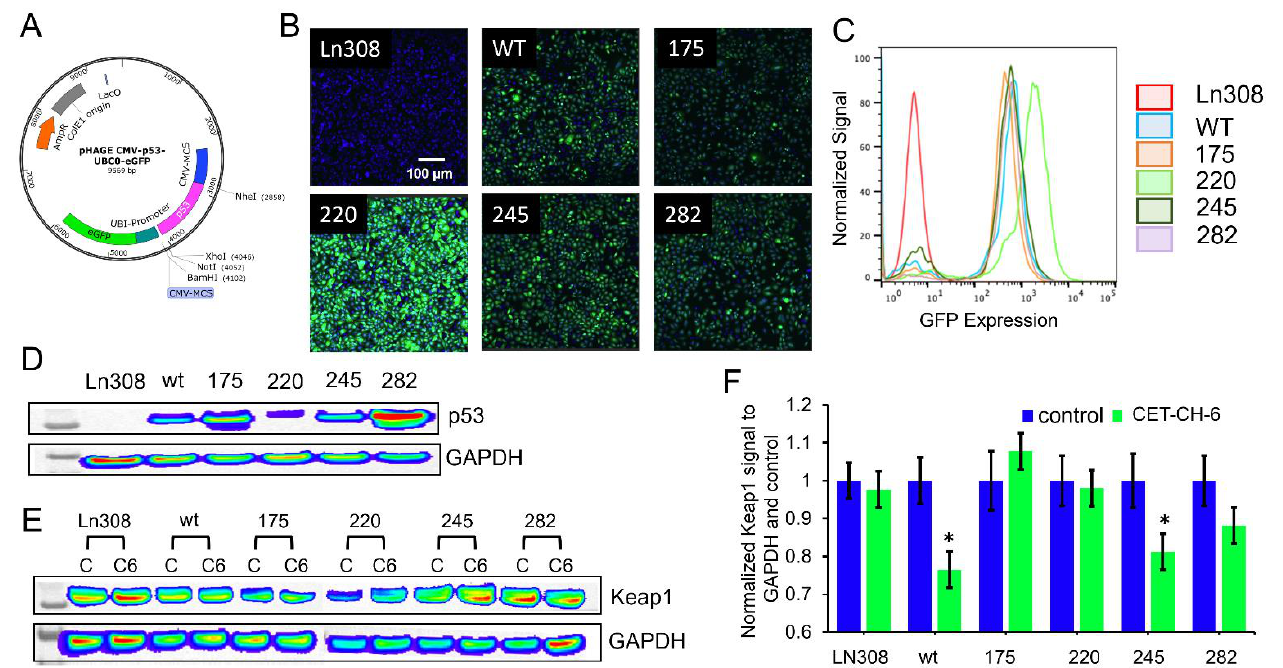
Figure 4. LN308 cell line with no p53 expression engineered to stably express structural p53 variants at different locations. ( A ) the vector designed for the transduction of LN308 cell line to stably express p53 wild-type as well as five different structural mutations in the frequently mutated sites at the DNA binding regions at amino acid residue 175, 220, 245, and 282. These six cell lines were used throughout the study to test the Nrf2 inhibitors and activators; ( B ) confocal microscopy of different clones of LN308 cell lines that stably express green fluorescence protein (GFP) after being transduced with a lentivirus vector constructed for expression of p53 and GFP; ( C ) flow cytometry analysis of different LN308 cell lines stably expressing p53 mutations and GFP; ( D ) Western blotting of LN308 cell lines stably expressing different p53 variants; ( E ) changes in Keap1 expression after treatment of different LN308 cell lines with CET-CH-6 (2.5 μM), with ( F ) quantitative plot normalized to GAPDH and control of each clone. Error bars represent mean ± SD. C: control and C6: CET-CH-6. For whole Western blot membranes, please refer to Figure S2. Keap1 in each cell line is compared to the control signal, and * represents p -value < 0.05.